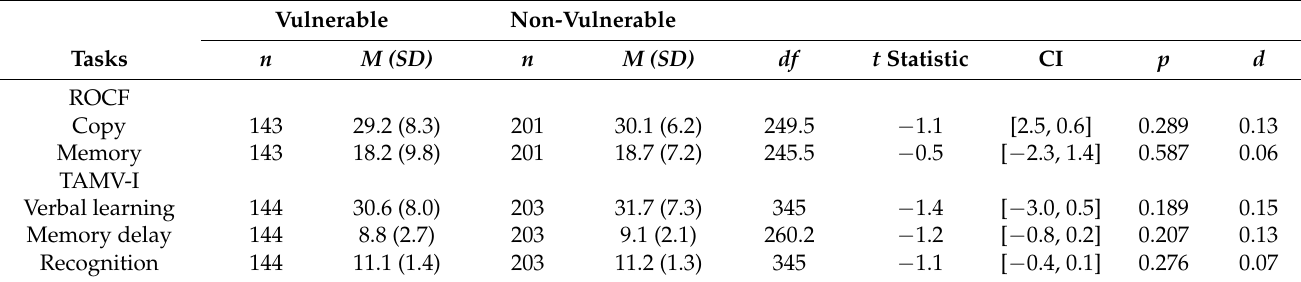
Table 1. Motor skills and memory tests raw scores and independent samples t -test results.